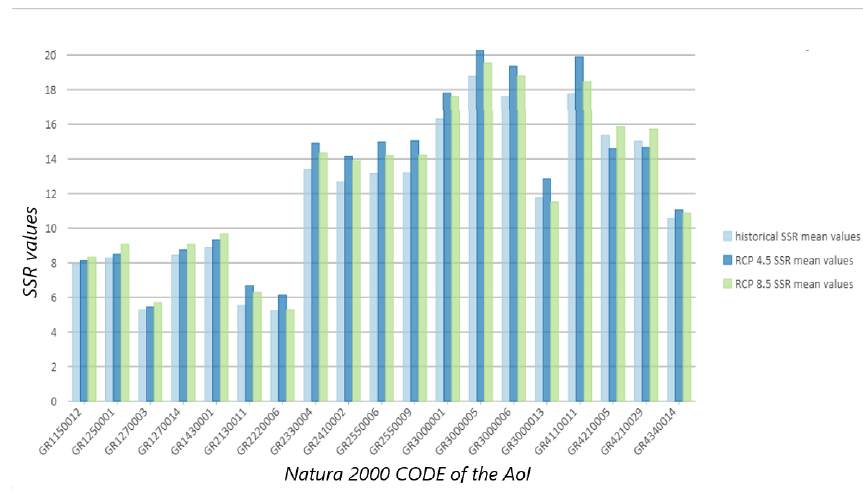
Figure 4. Bar chart of historic Seasonal Severity Rating (SSR) value, RCP 4.5 SSR value and RCP 8.5 SSR value by Area of Interest (AoI). Forests 2020 , 11 , x FOR PEER REVIEW